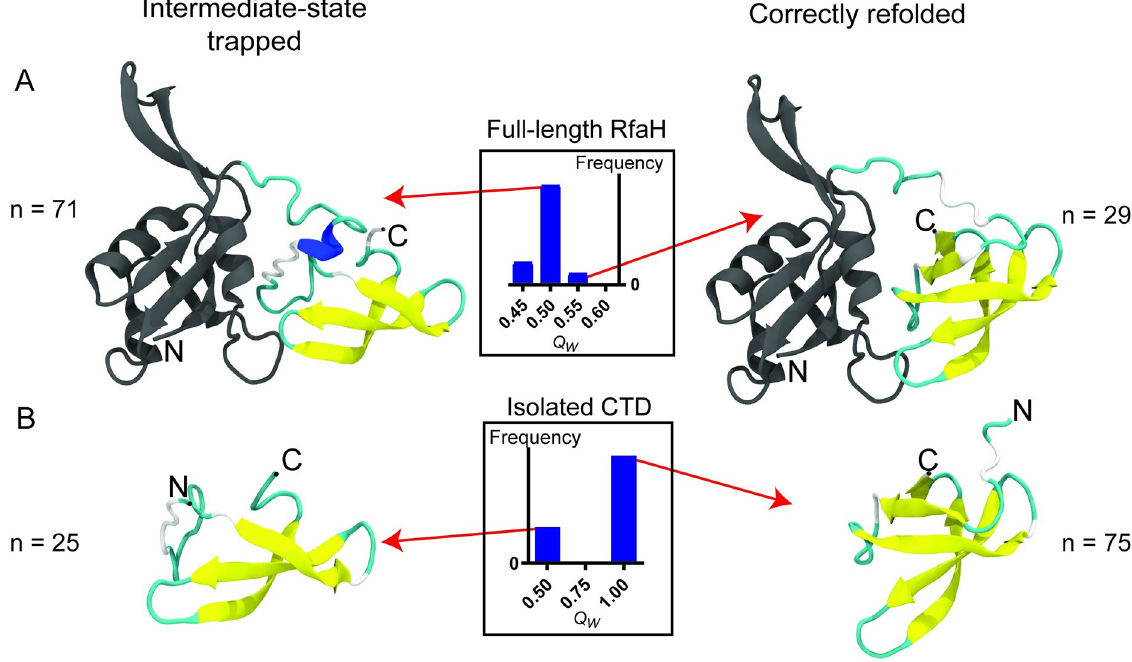
Fig 4. Refolding of β CTD in the context of the full-length protein and in isolation. Representative final structures after β CTD refolding in the context of the full-length protein (A) and in isolation (B). The histograms represent the Q intermediate state is formed by the three largest β -strands that form the CTD barrel, namely strands β 2, β 3 and β 4.